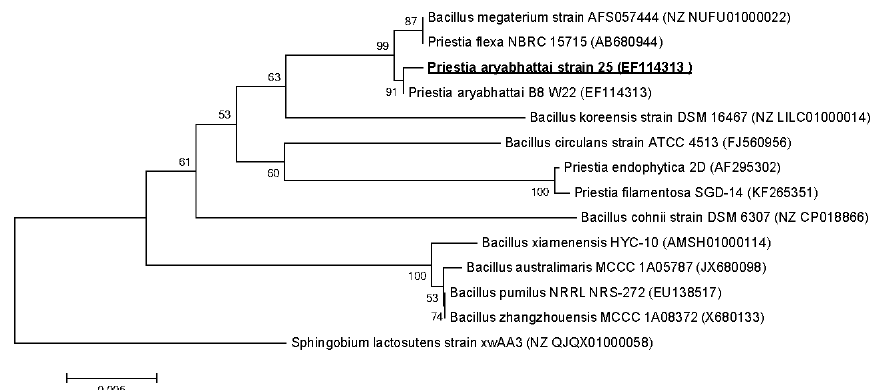
Figure 6. Phylogenetic position of strain Priestia aryabhattai 25 based on the results of the comparative analysis of the nucleotide sequences of the 16S rRNA genes. The scale corresponds to 5 nucleotide substitutions per every 1000 nucleotides (evolutionary distance). The neighbor-joining method was used. The root was determined by including the sequence of Sphingobium lactosutens strain xwAA3 (NZ QJQX01000058) as an external group.